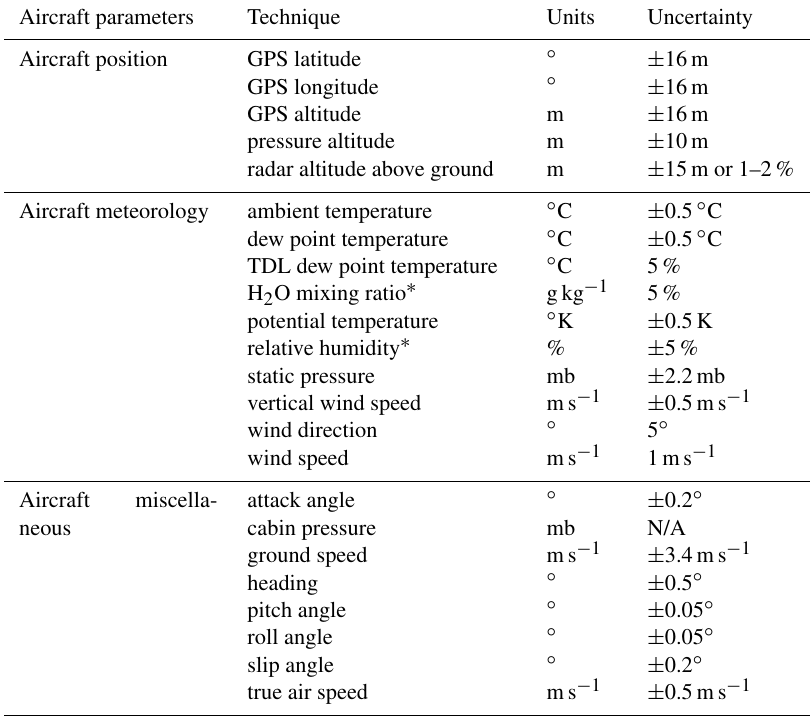
Table 1. Standard NOAA WP-3D provided parameters. Aircraft parameters Technique Units Uncertainty Aircraft position